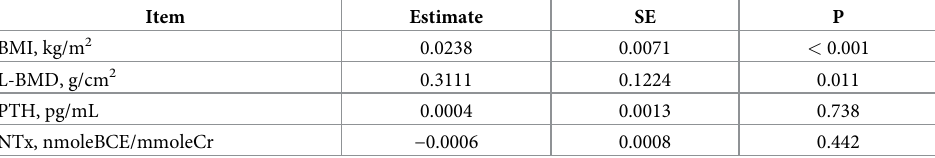
Table 4. Multiple regression analysis for serum